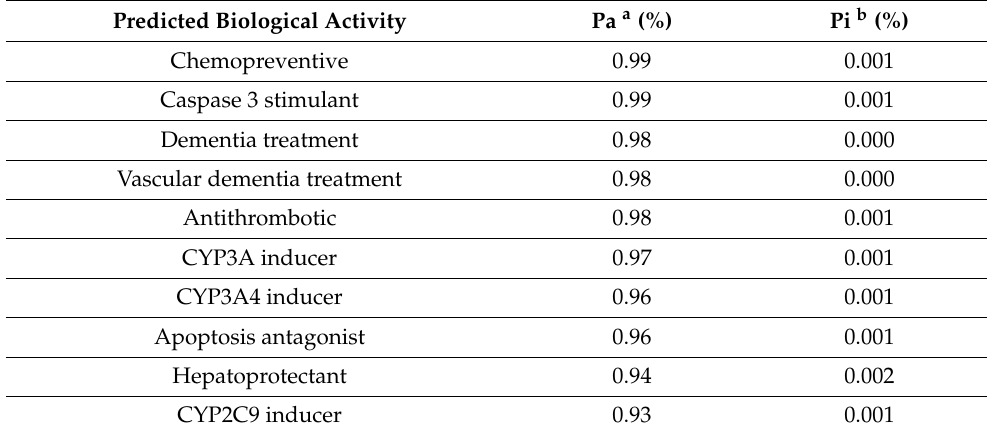
Table 3. Predicted biological activity of ginsenoside Rh1.